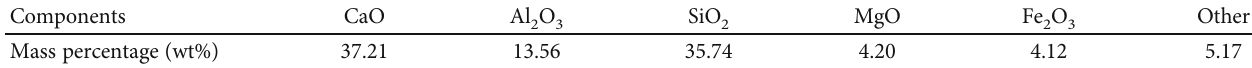
Table 1: Chemical composition of construction